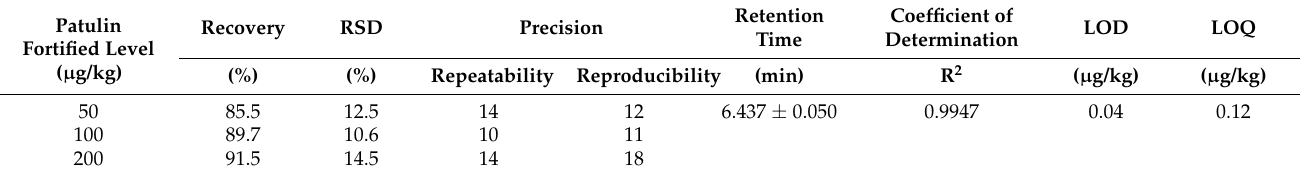
Table 1. Recoveries analysis of patulin (PAT) in citrus